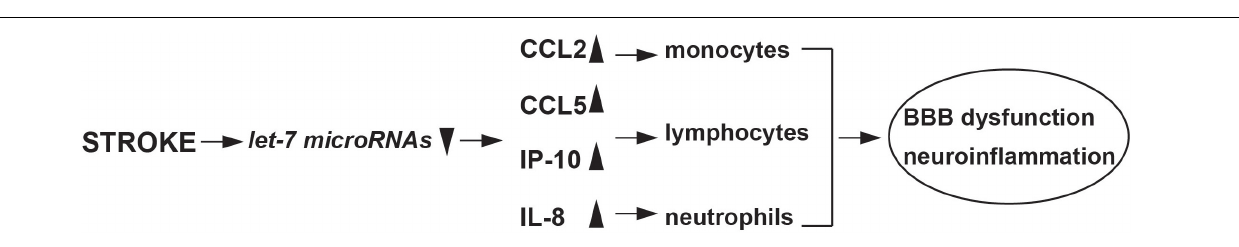
FIGURE 4 | Schematic of stroke induced let-7 miRNAs changes and immune